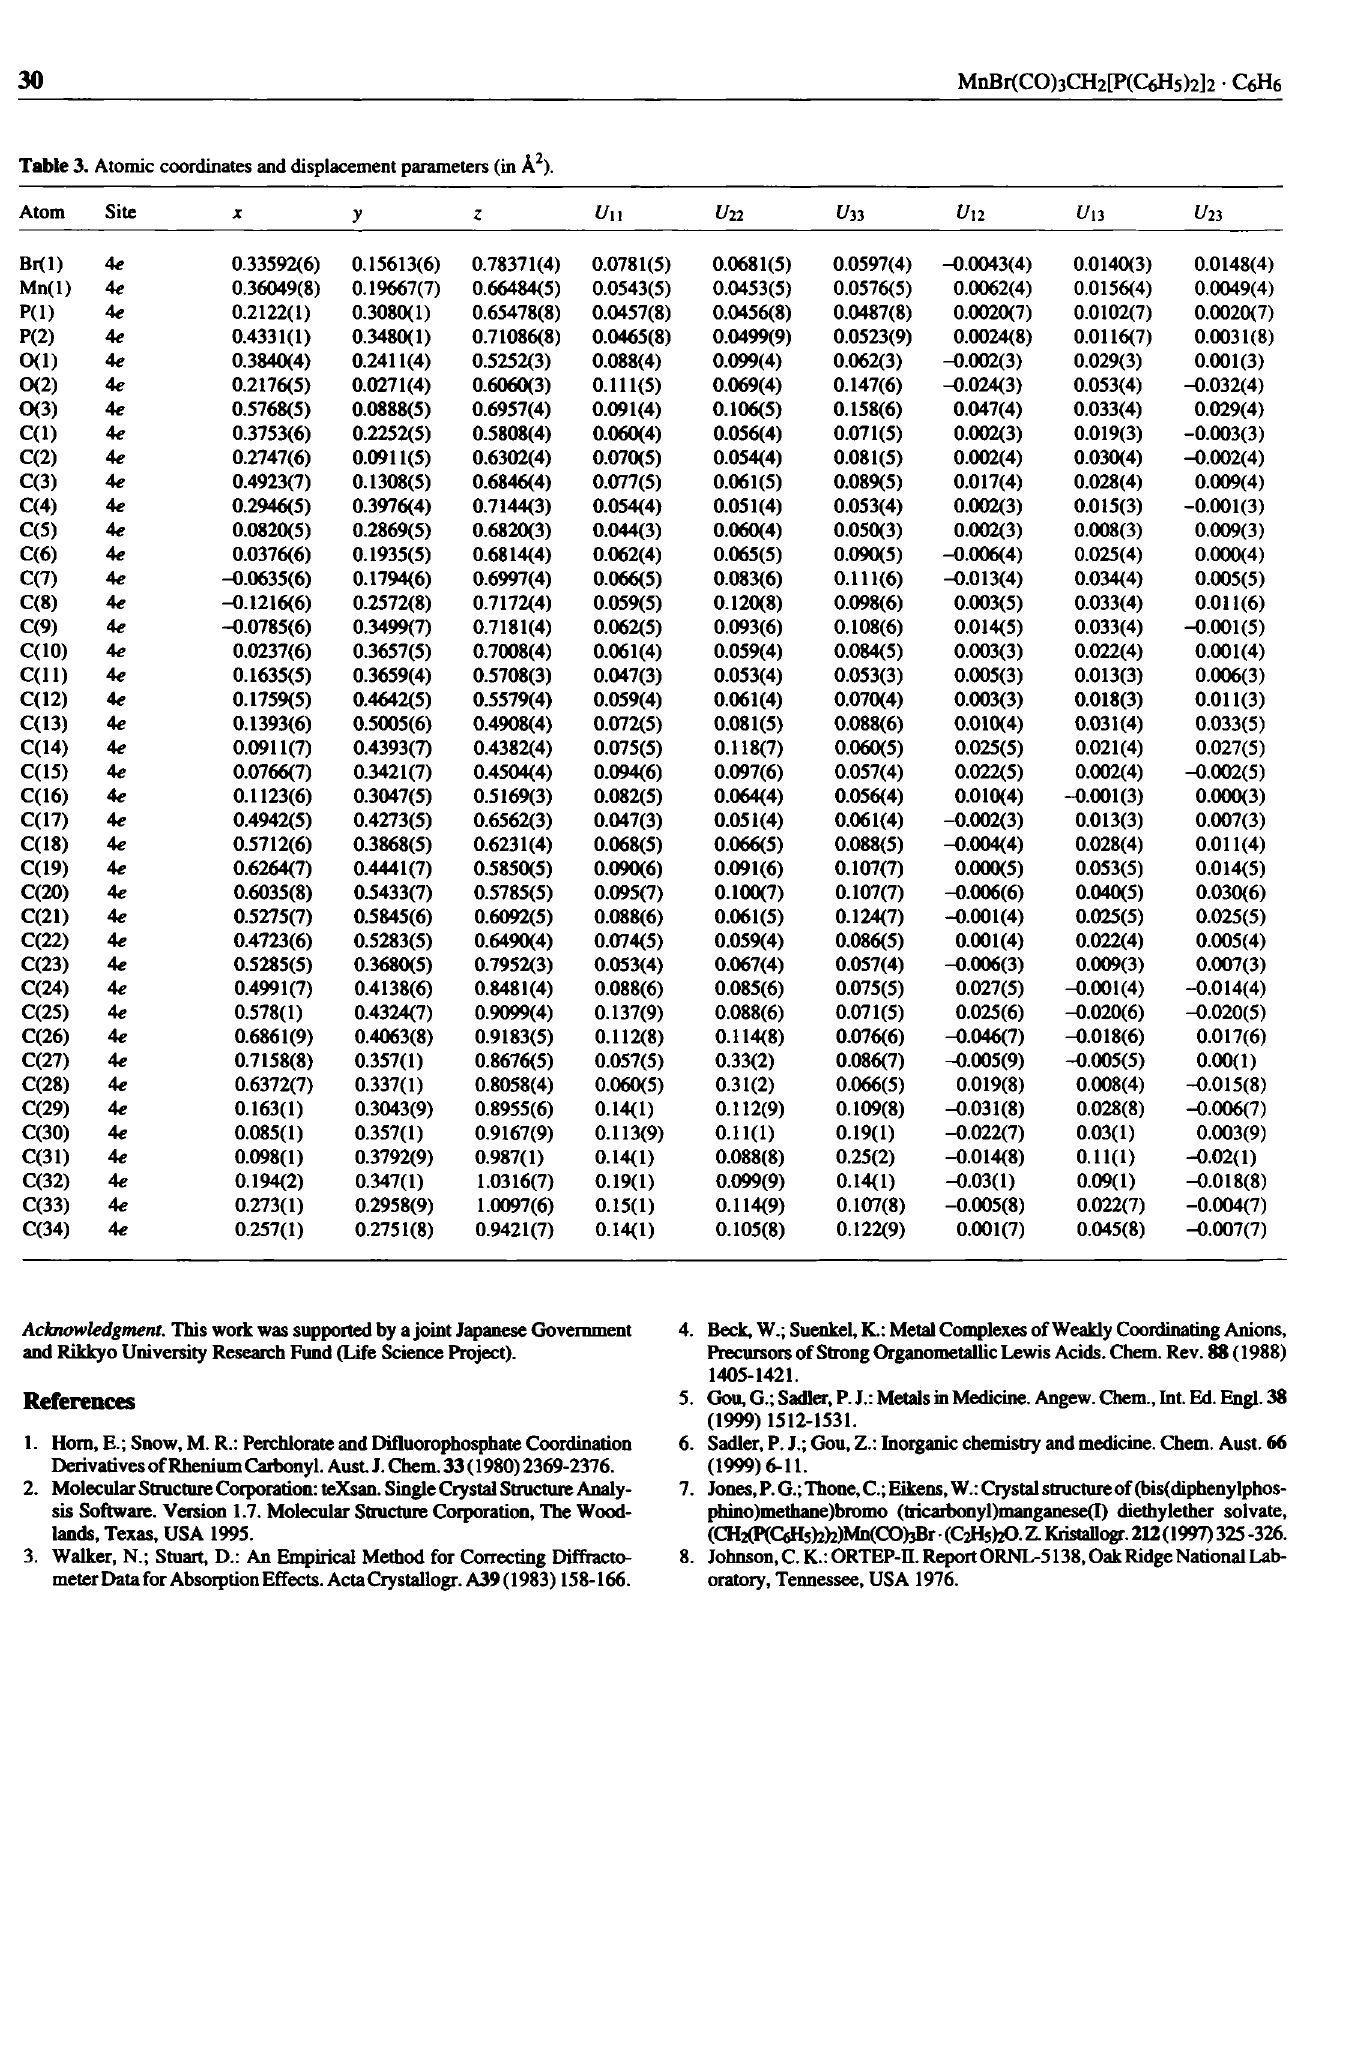
Table 3. Atomic coordinates and displacement parameters (in A 2